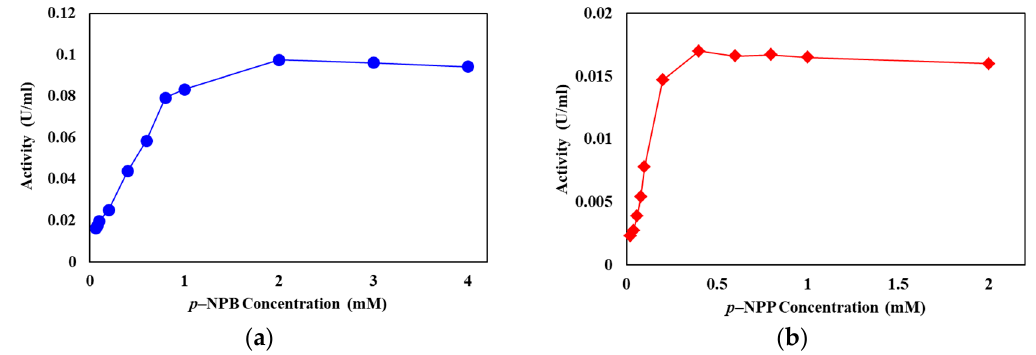
Figure 5. Rate of LysB-D29 catalyzed reaction with di ff erent concentrations of ( a ) p -NPB and ( b ) p -NPP. Twenty microliters of LysB-His 6 enzymes were added to 180 µ L of p -NPL and p -NPP, respectively (1 mM dissolved in 20 mM Tris-HCl, 100 mM NaCl, 0.1% Triton X-100, pH 8), the reaction mixture was incubated at 37 ◦ C and the release of p -nitrophenol was recorded at 410 nm at 1 min intervals.